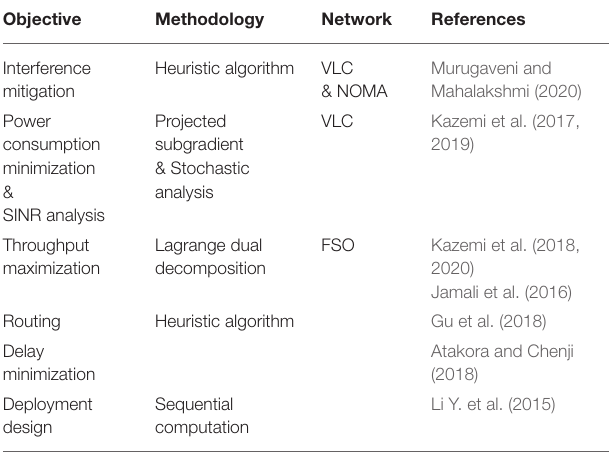
TABLE 5 | Taxonomy of literature in section